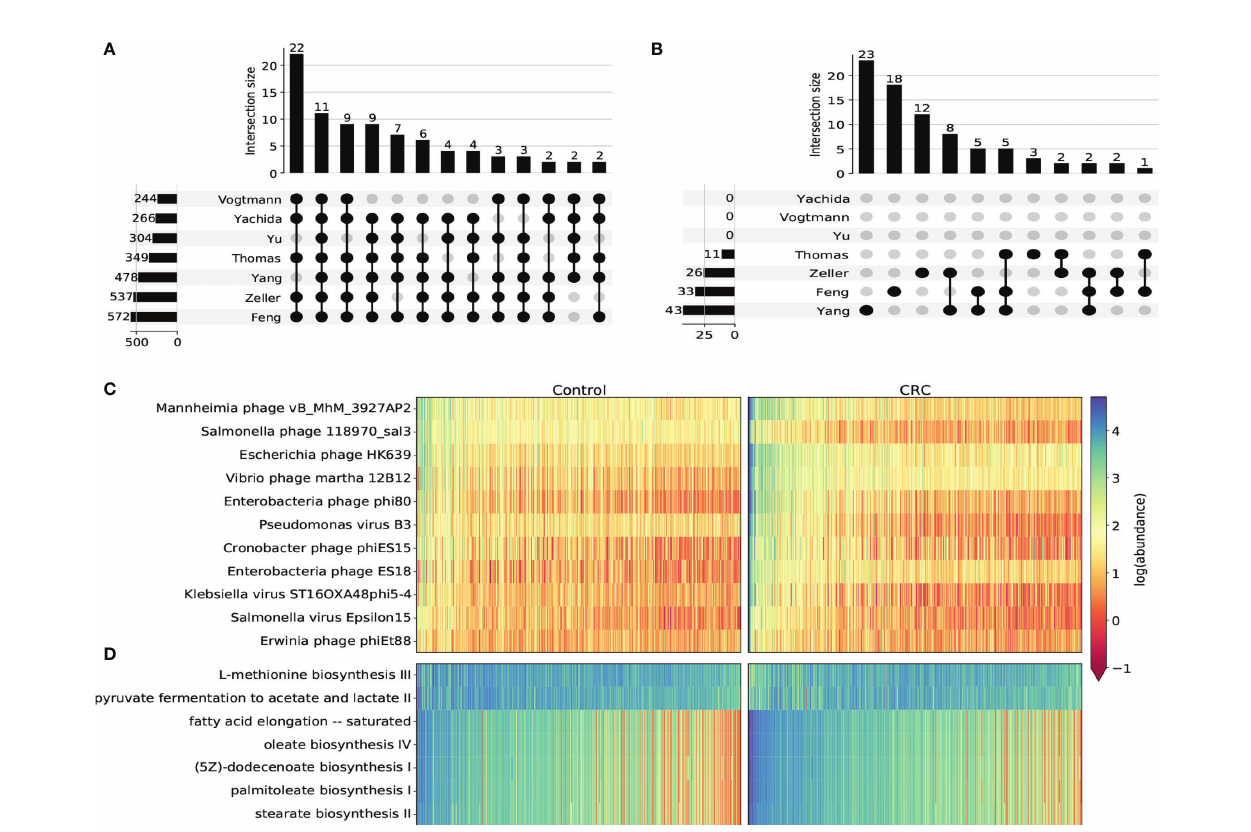
FIGURE 3 | Differential abundance analysis on taxonomic and functional viral pro fi les. (A) UpSet plot showing the number of shared differentially abundant viral species determined by species-level TMM normalized abundance and DESeq2. Only viral species differentiated in at least 5 datasets were displayed. (B) UpSet plot showing the number of shared differentially abundant viral pathways determined by HUMAnN3 pathway abundance and DESeq2. (C) Heatmap showing the log transformed TMM normalized abundance of viral species differentiated in all 7 datasets. (D) Heatmap showing the log transformed HUMAnN3 pathway abundance of pathways differentiated in at least 3